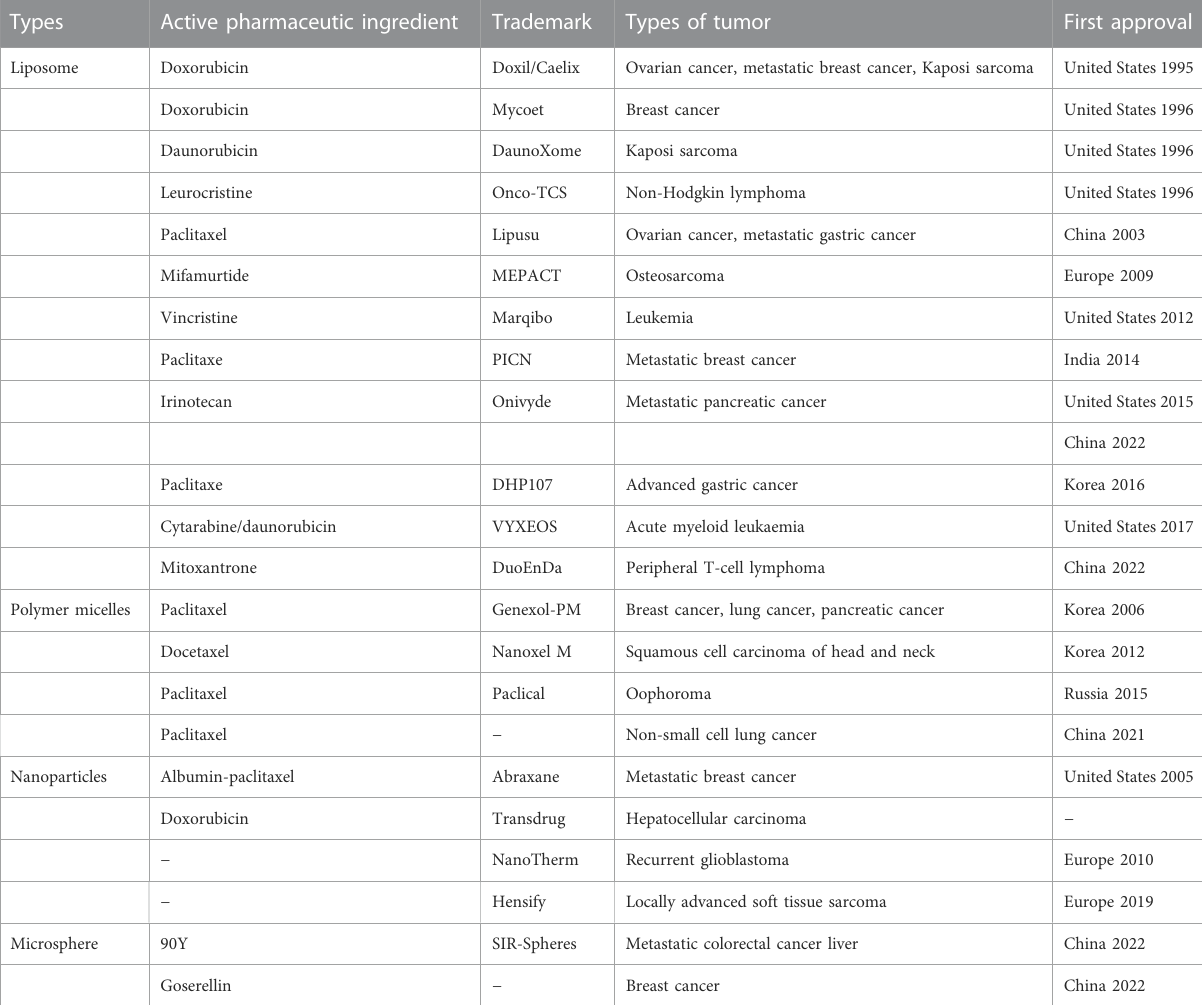
TABLE 1 Some approved anti-tumor